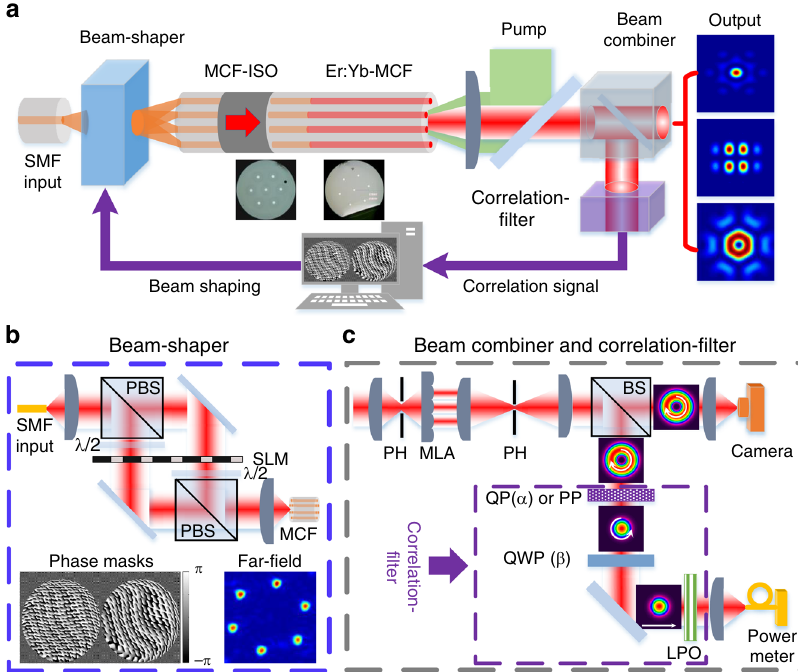
Fig. 2 Schematic of the experimental setup. a MCF ampli fi er: a single seed laser beam is adaptively shaped by a spatial beam-shaper and the resultant fi eld used to excite the individual cores of the MCF ampli fi er; multiple ampli fi ed beams are coherently combined to obtain various spatial modes in the far- fi eld. b Beam-shaper: the input beam is split into the two orthogonal linear polarizations, each of which is split into N beams: the phases and amplitudes of these two components are then independently modulated by the SLM. The N pairs of orthogonally linear-polarized beams are recombined to form N beams with well-de fi ned polarizations and phases, and are then coupled into the individual cores of the MCF. An example of phase masks displayed on the SLM and the generated 6 independent beam spots in the plane of the MCF core. c Adaptive coherent beam combination setup: the multiple output beamlets are collimated by a microlens array (MLA) and are combined by a focusing lens in the far- fi eld; the shaped beam is characterized by a spatial mode correlation- fi lter consisting of a properly aligned q -plate (QP) (or a phase plate (PP)), a quarter-waveplate (QWP) and a linear polarizer (LPO). The resulting correlation signal is detected by a single-mode fi bre (SMF) pigtailed power meter, where the measured power is used as the merit function for the iterative optimisation algorithm. ISO isolator; PBS polarization beam splitter; PH pin-hole; BS polarization-insensitive beam